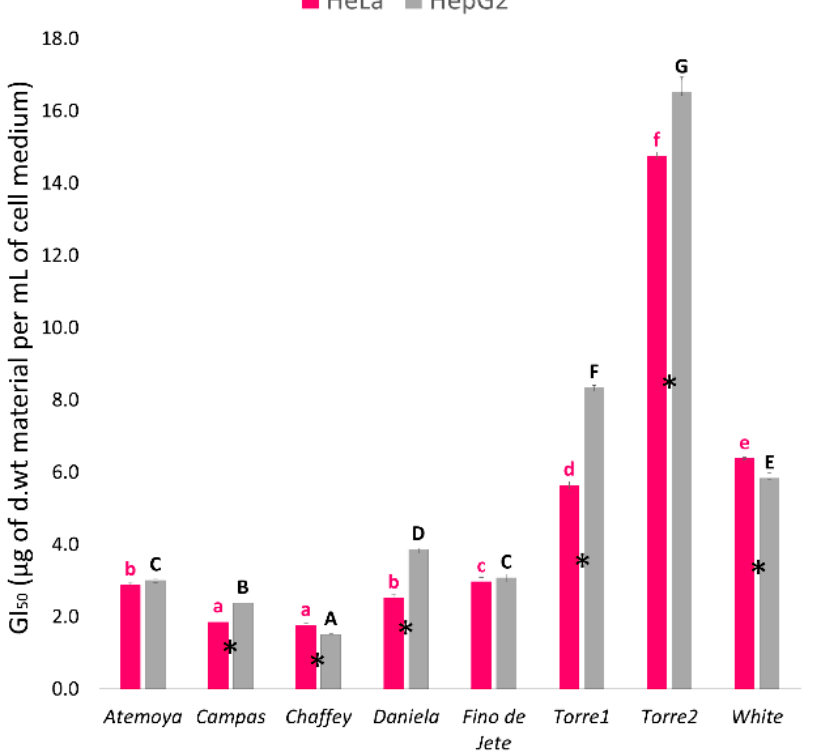
Figure 3. Antiproliferative activity of the seven extracts of Cherimoya and Atemoya leaves against HeLa and HepG2 tumor cell lines. Cell growth was measured by MTT assay after 48 h of treatment with different concentrations of each leaf extract and was expressed as GI50 ( μ g of d.wt. weight per mL of cell medium). In the histogram, each column represents the mean ± SD of three independent experiments. Among the same series (HeLa or HepG2), different letters indicate significant differences at p ≤ 0.05 as measured by Tukey’s multiple range test. Letter “a” denotes the highest antiproliferative activity. “*” indicates statistical differences between the two cancer cell lines. For additional statistical analysis information see Supplementary Table S3.